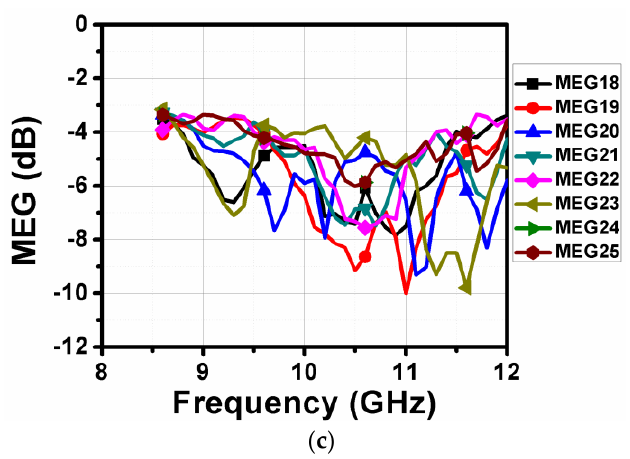
Figure 36. MEG of the 8-element communication antennas associated with ( a ) ports 2 to 9, ( b ) ports 10 to 17, and ( c ) ports 18 to 25.